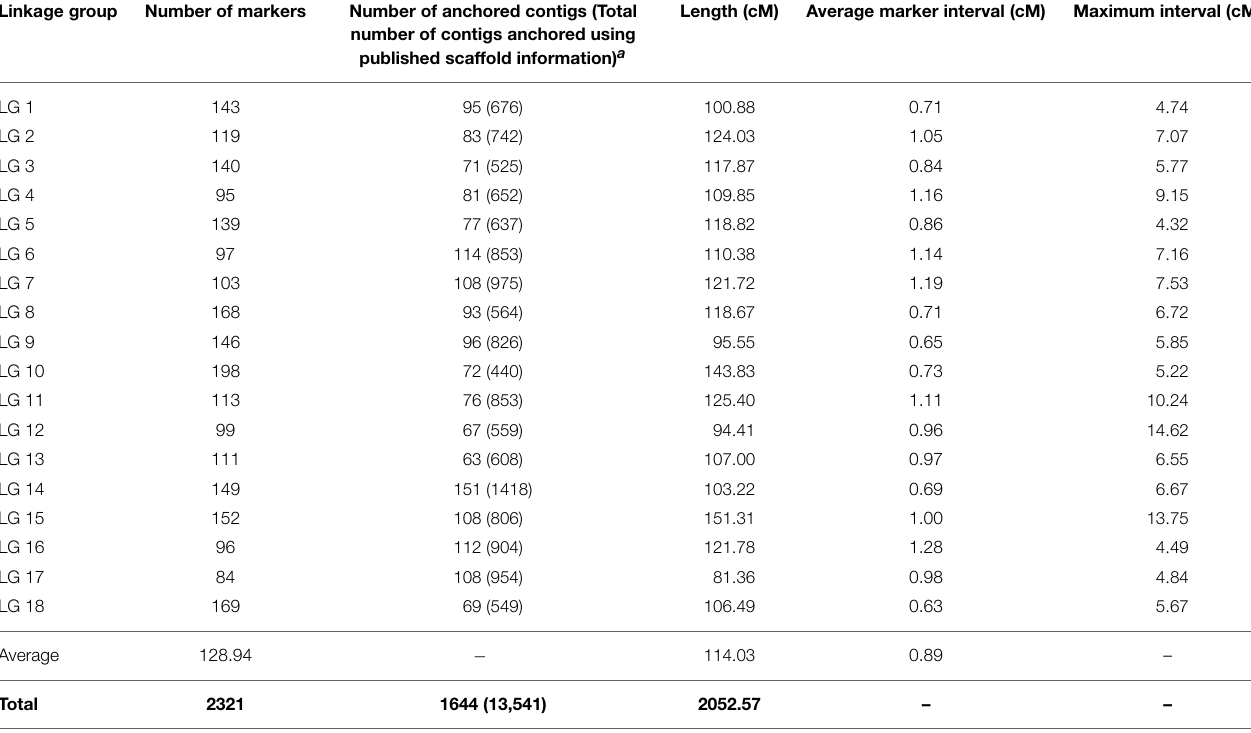
TABLE 4 | Distribution of SNP markers on the integrated linkage map. Linkage group